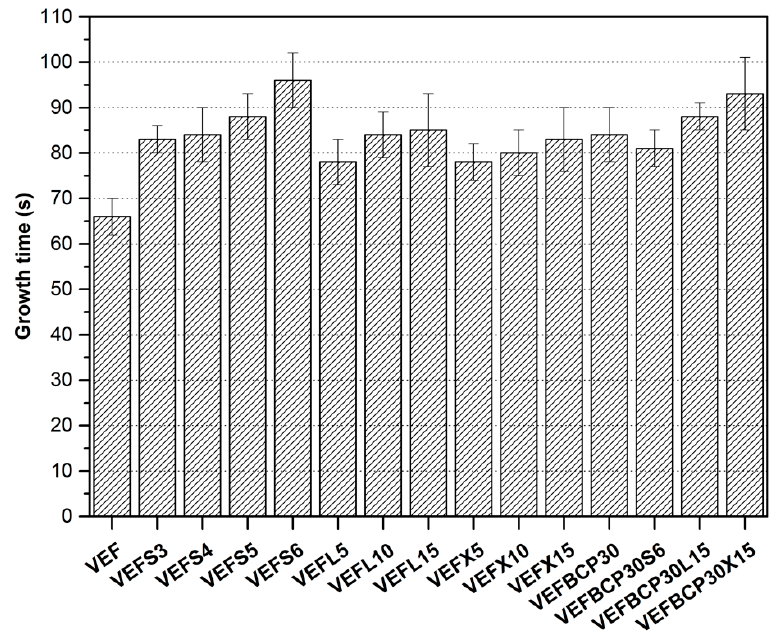
Figure 1. The growth time of VEF composites.